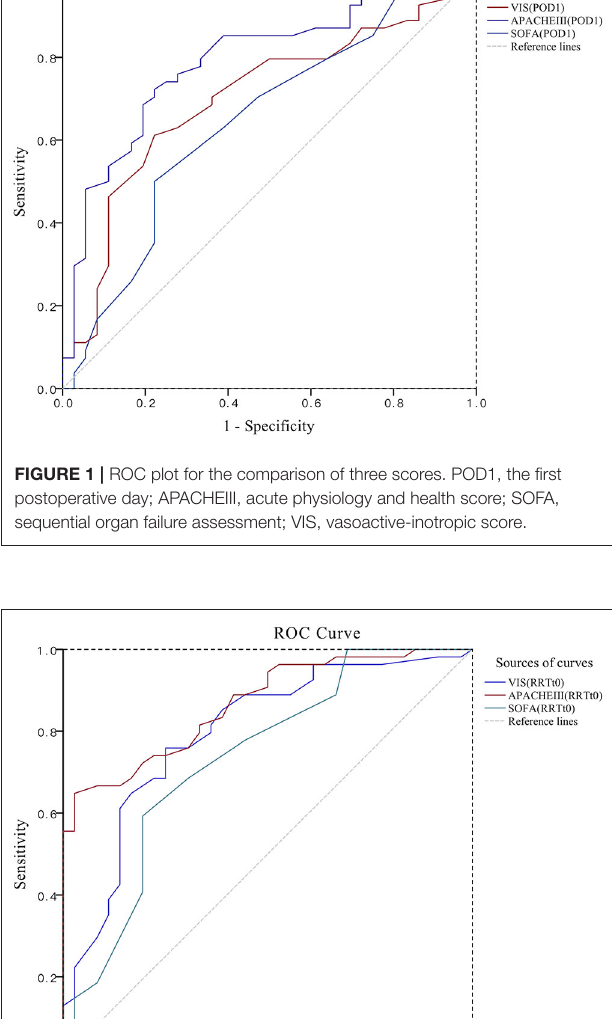
significant in previous studies (time from AKI to RRT) were included in the multivariable binary logistic regression